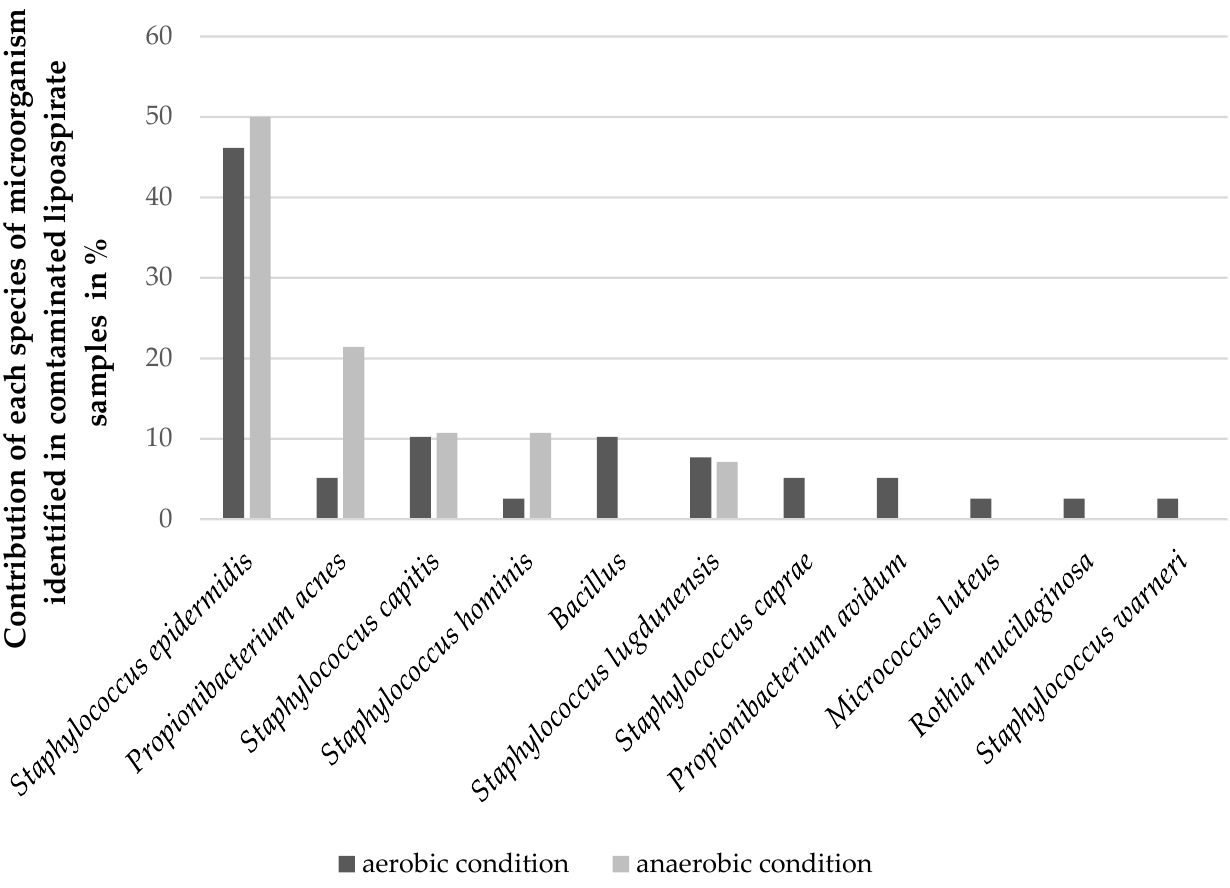
Figure 3. The frequency of individual microorganisms isolated from contaminated lipoaspirates identified after incubation under aerobic and anaerobic conditions. All isolated bacteria of the Bacillus genus are presented together.